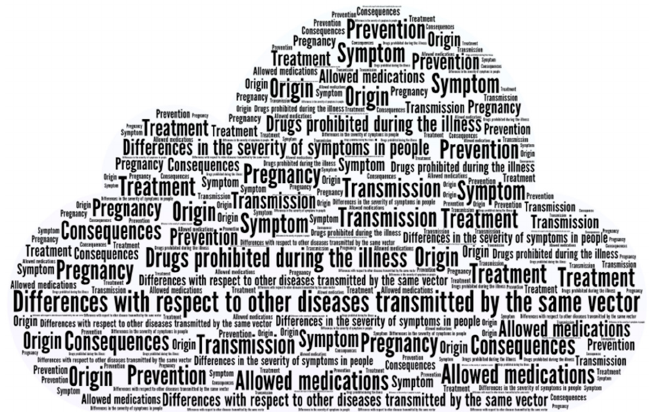
Figure 1. Word cloud for the open question: “What aspects do you not understand or are confusing for you about Zika?”.